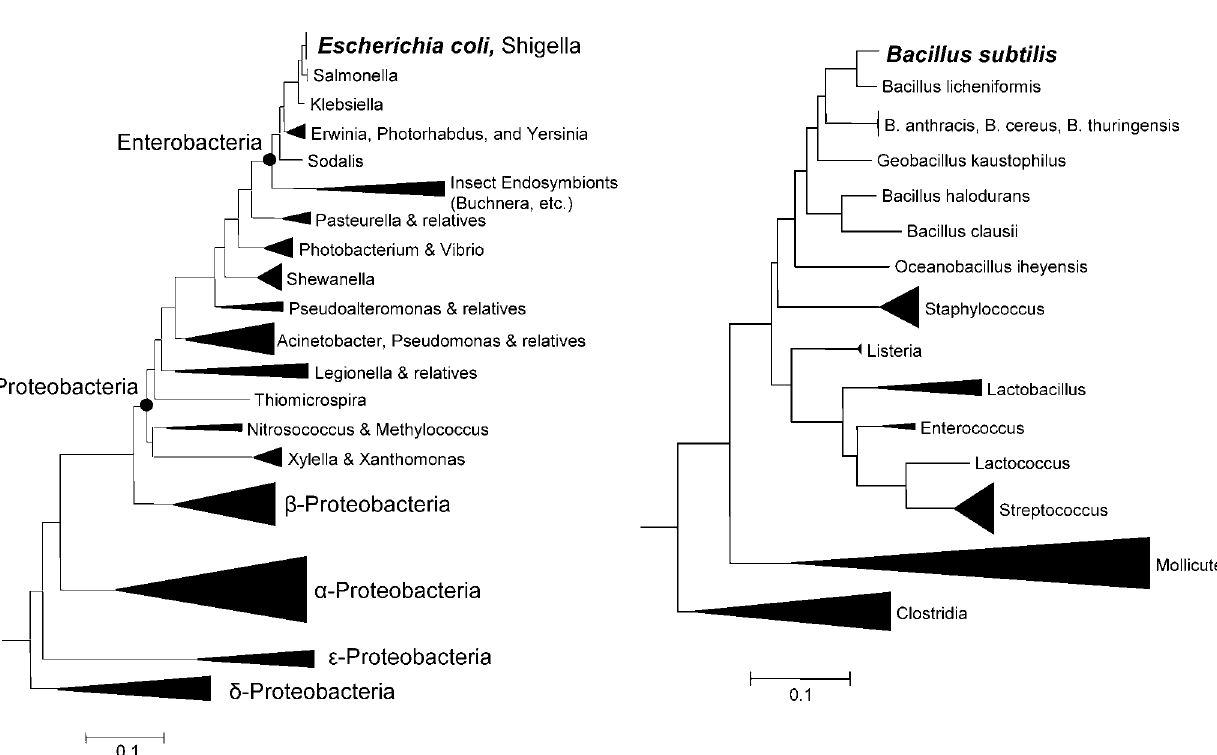
Figure 1. Phylogeny of Sequenced Members of the Proteobacteria and the Firmicutes